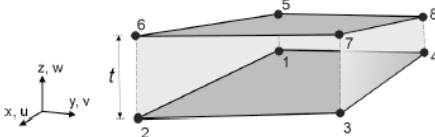
Figure 4: Zero thickness cohesive element. Figure retrieved from